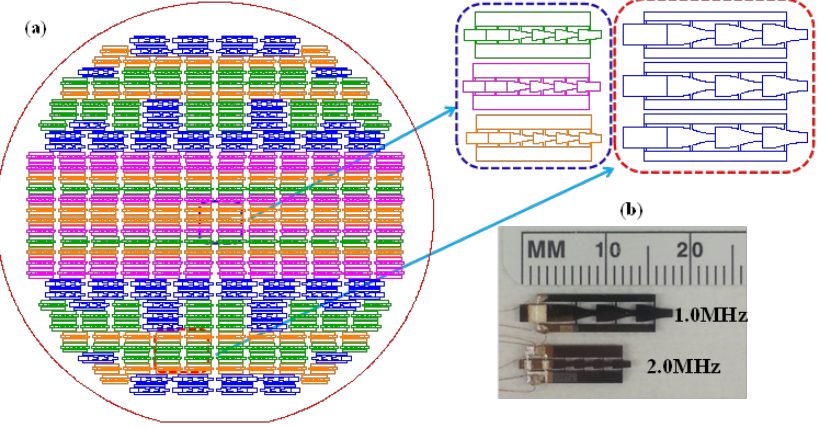
Figure 3. ( a ) Layout of nozzles in an 8-inch silicon wafer; ( b ) MEMS-fabricated 1.0 and 2.0 MHz